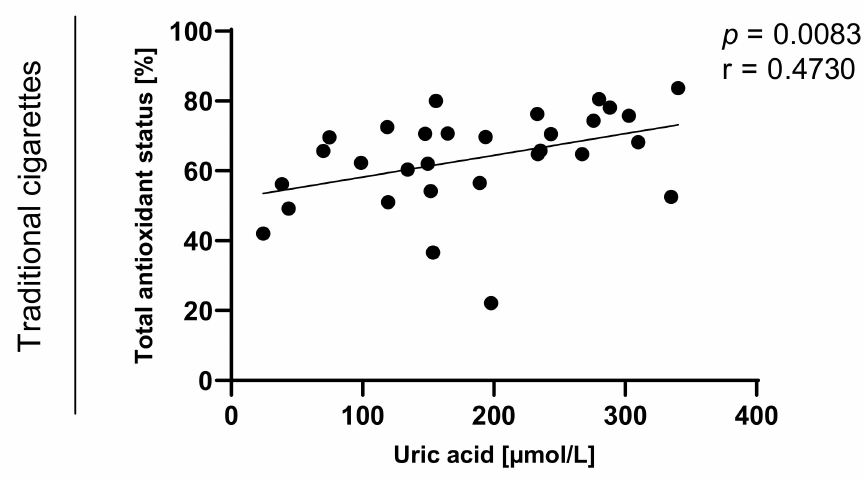
Figure 9. Correlation between uric acid and TAOS (total antioxidant status) among traditional cigarettes smokers.